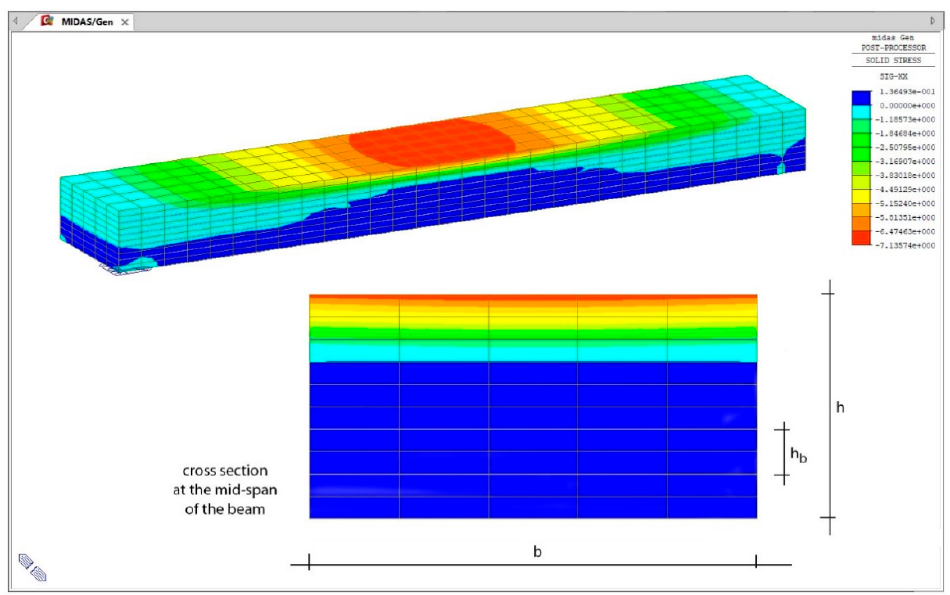
Figure 6. Distribution of normal stresses [MPa] in the mid-span cross-section of the FEM masonry beam.